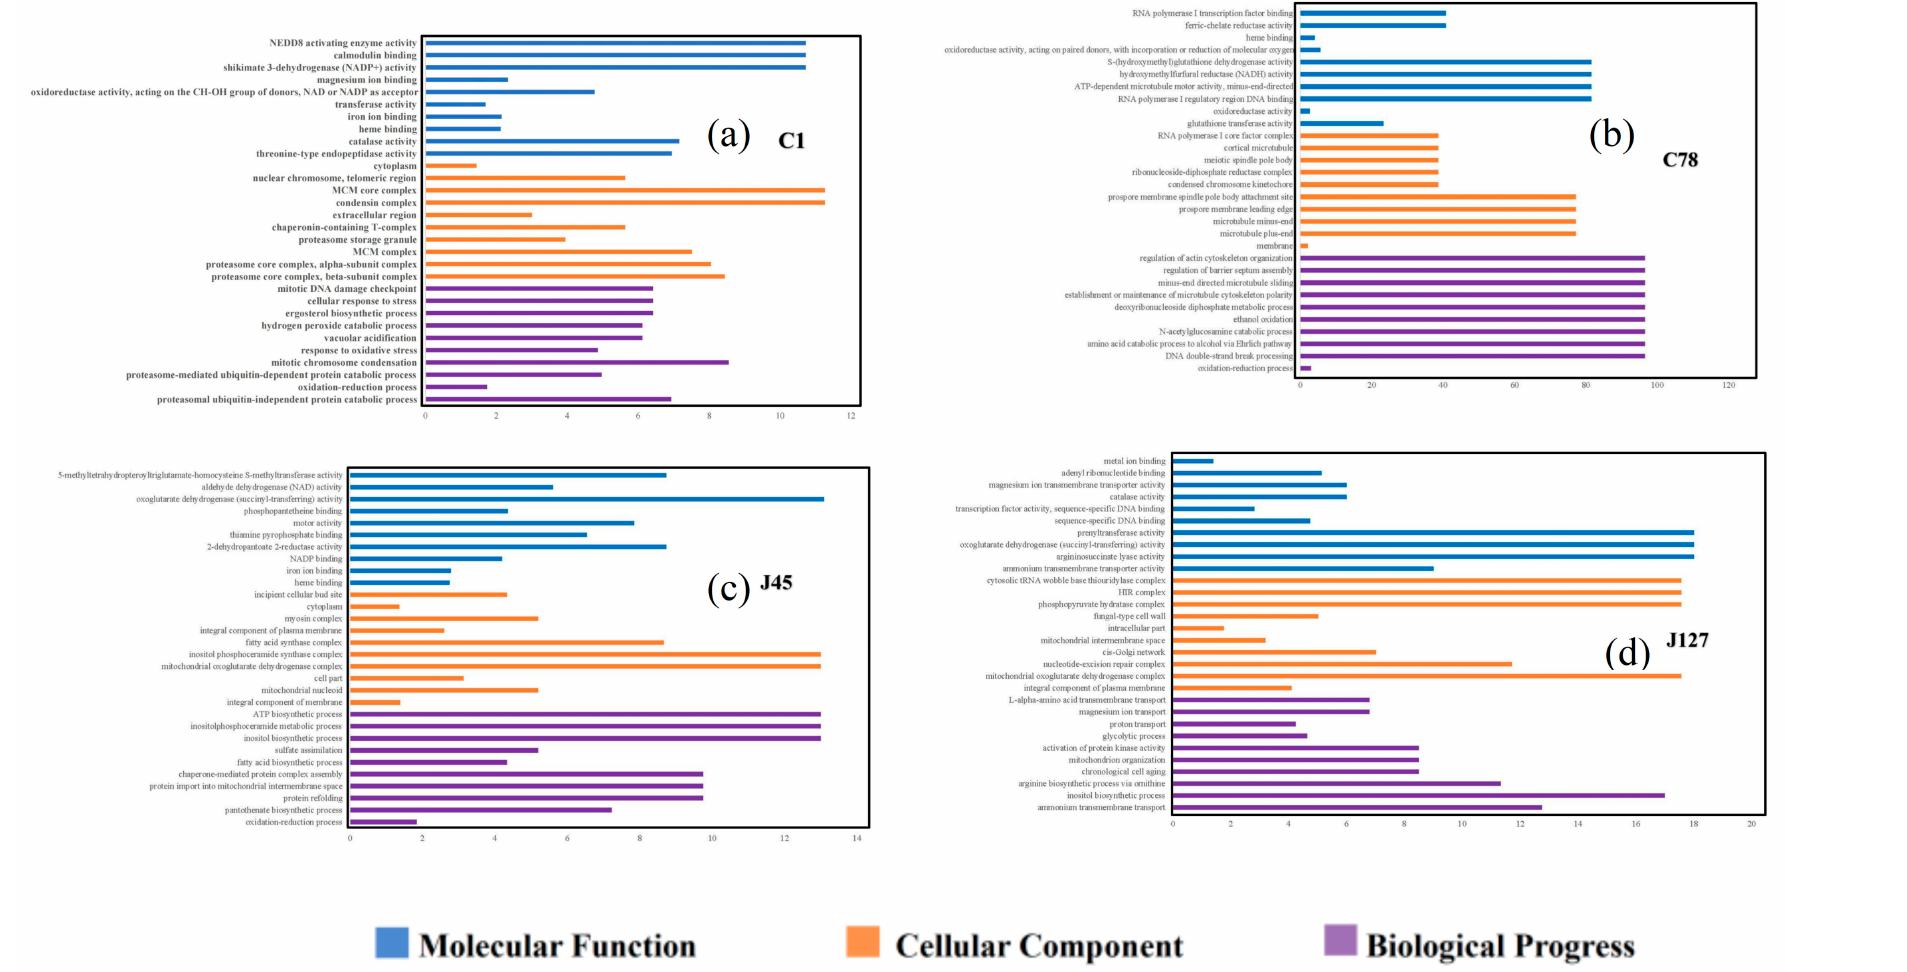
Figure 6. GO enrichment analysis of the DEGs in four strains of C. geophilum after 2 mg/L Cd treatment as compared to the same strains cultured in normal conditions (0 mg/L Cd). Y axis represents different regulatory pathway in the molecular function (blue), cellular component (yellow), and biological progress (purple) categories, respectively. X -axis represents the numbers of DEGs involved in the corresponding